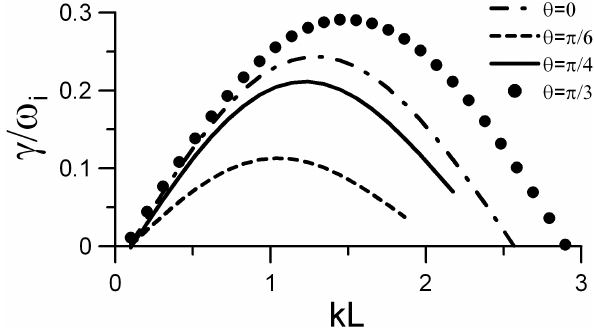
Fig. 3. Growth rate as a function of the magnitude of wavenum- ber k for polarizations A = A y e y + A z e z . The parameters have the following values: τ = 3, L CS = 0 . 6 ρ i , b n = 0 .